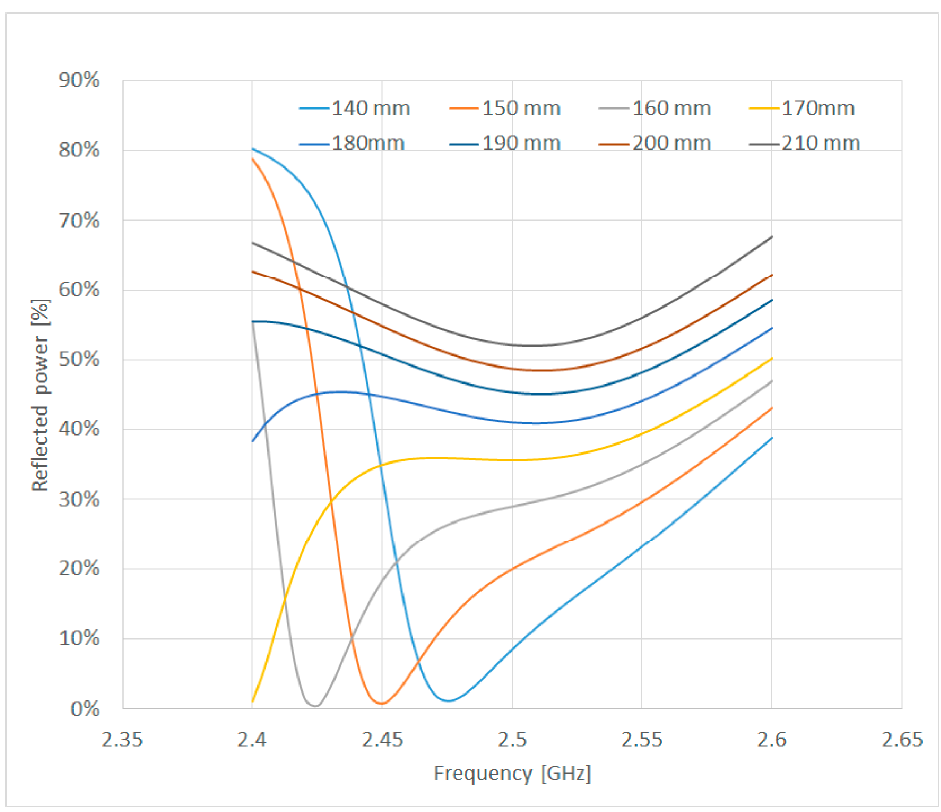
Figure 3. Reflected power (|S11| 2 ) as a function of the doorknob transition dimensions (plunger distance from the center of the doorknob transition).